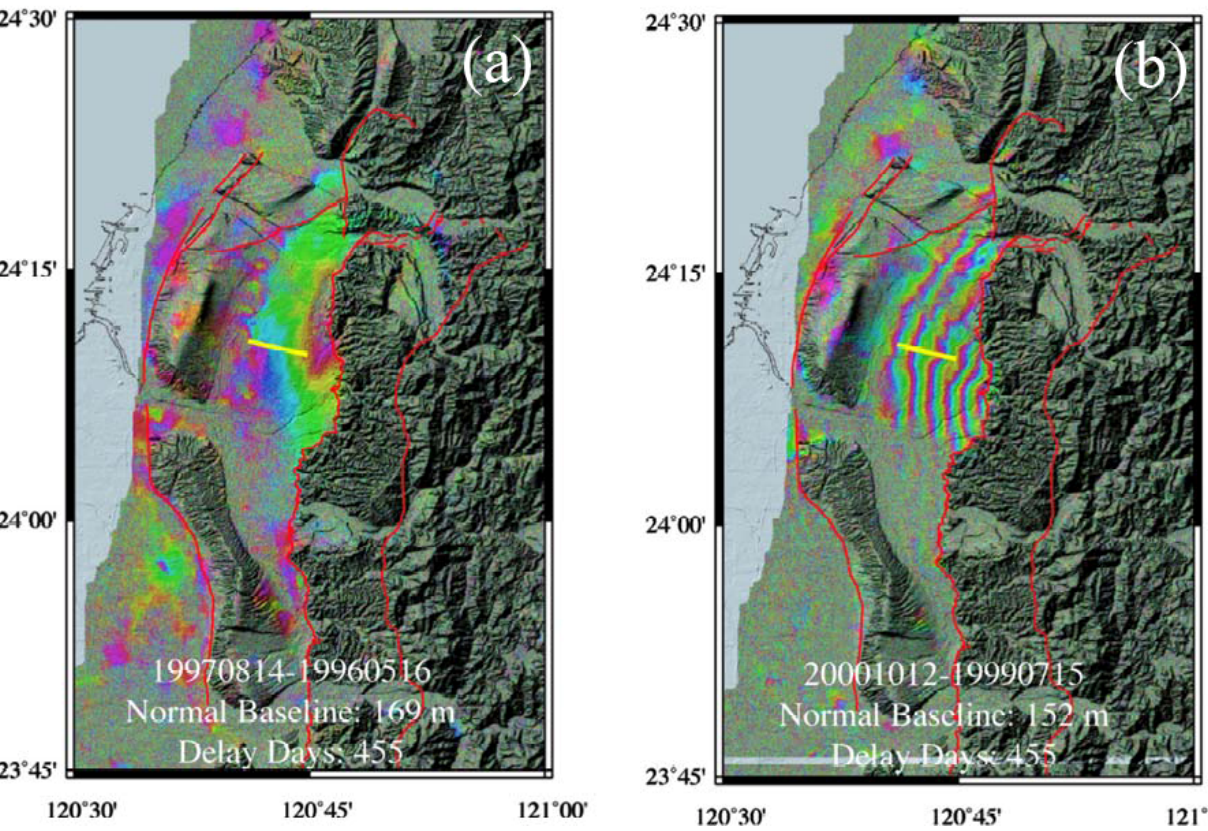
Figure 7. Pre-seismic and co-seismic ground deformations for the Chi-Chi earthquake (M = 7.6, 20 September 1999, Taiwan). (a) Pre-seismic deformations between 16 May 1996 and 14 August 1997. (b) Co-seismic ground deformations between 15 July 1999 and 12 October 2000